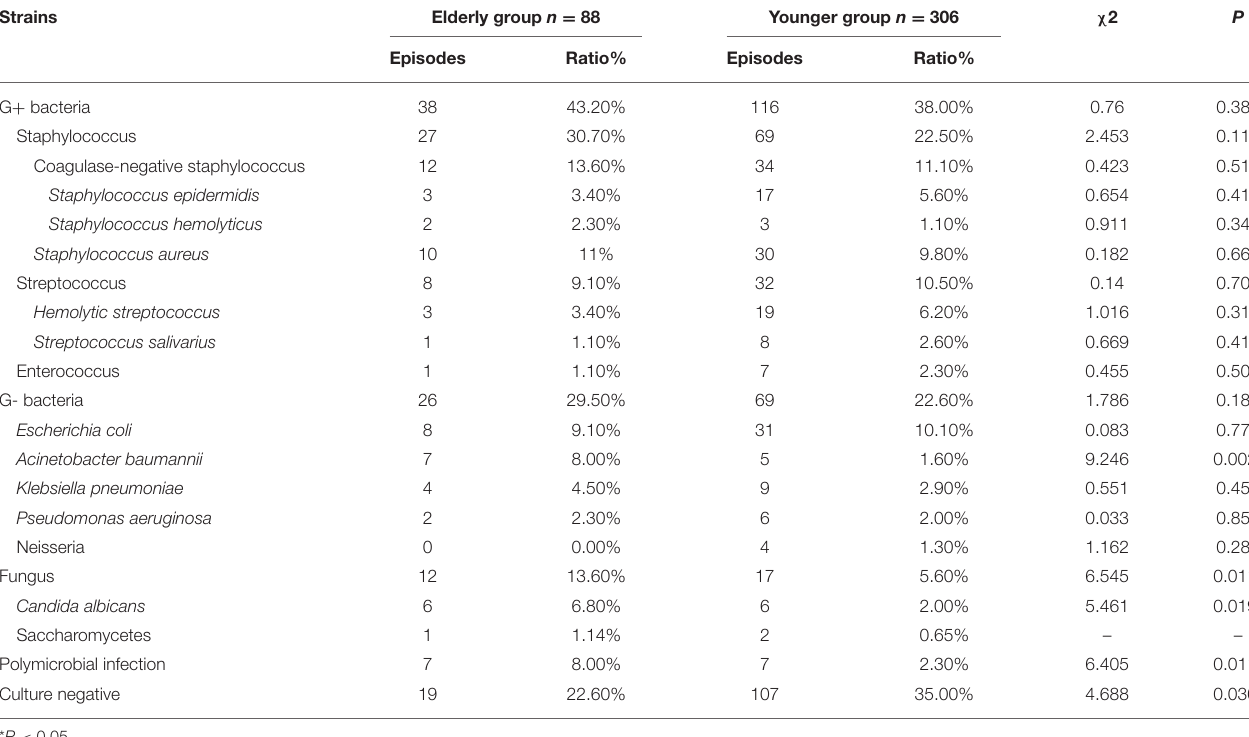
TABLE 2 | Causative organisms distribution in elderly and younger patients with PD related peritonitis. Strains